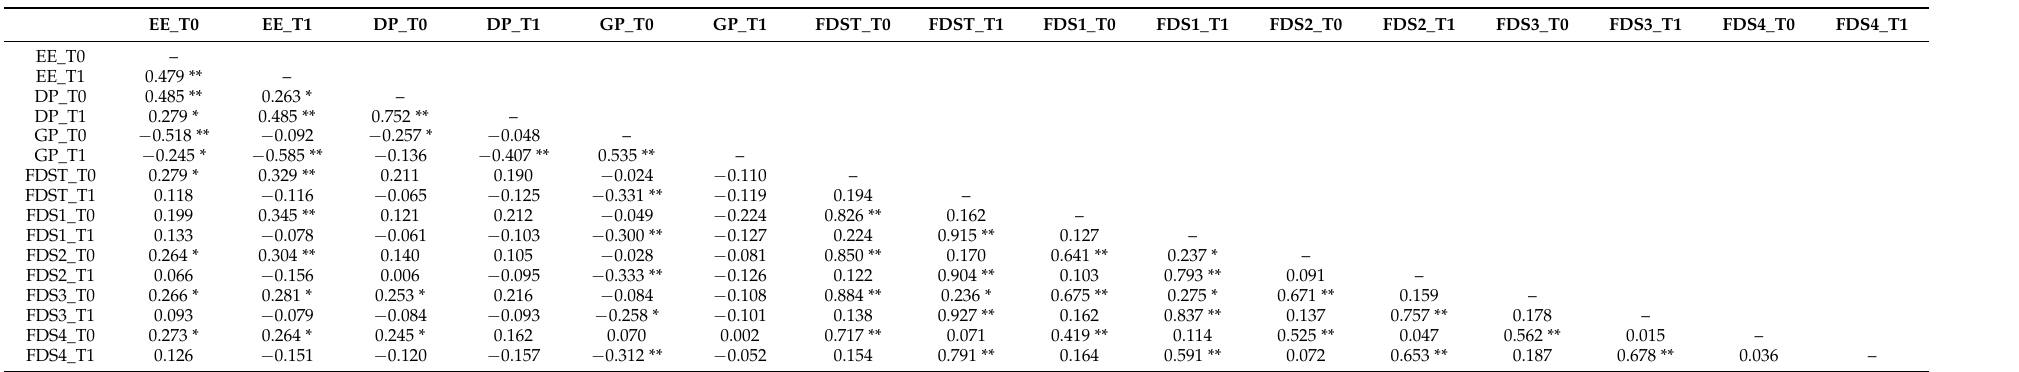
Table A1. Association between Maslach Burnout Inventory and Frustration Discomfort Scale.